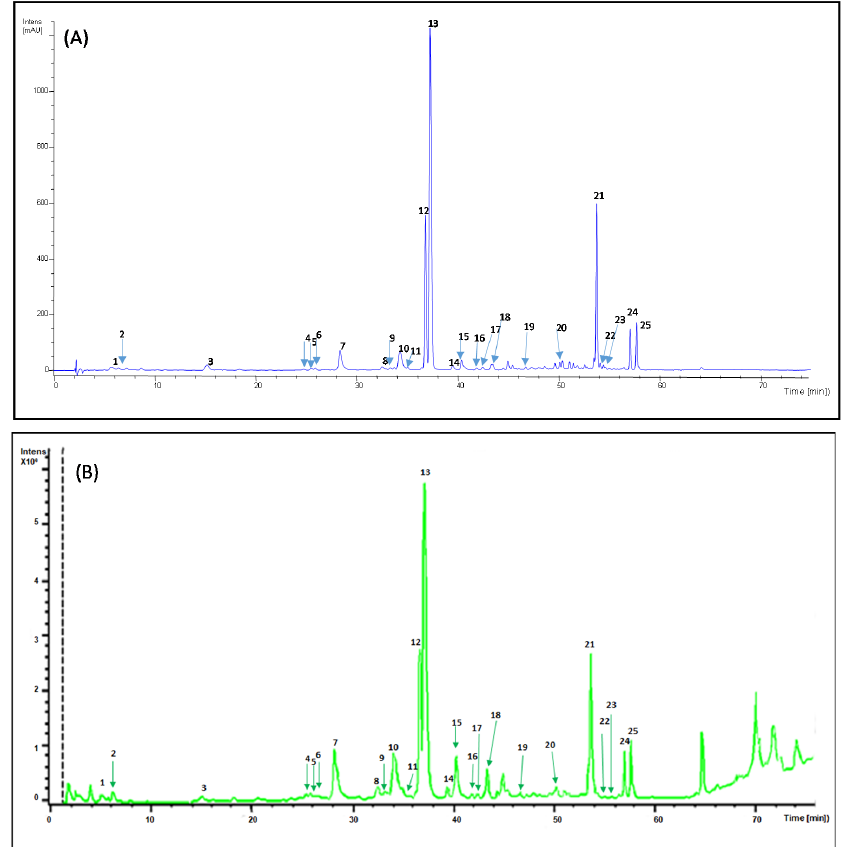
Figure 1. ( A ) The HPLC-UV chromatogram of Buddleja globosa obtained at 320 nm. ( B ) Total ion chromatogram (TIC) 100–1000 m/z of the 80% methanol extract of Buddleja globosa . The peaks numbers are the same of Table